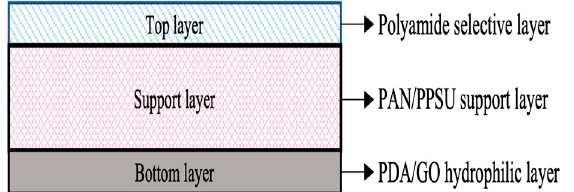
Figure 1. Schematic illustration of TFC membrane with PDA/GO coating layer. Note: Not to scale.